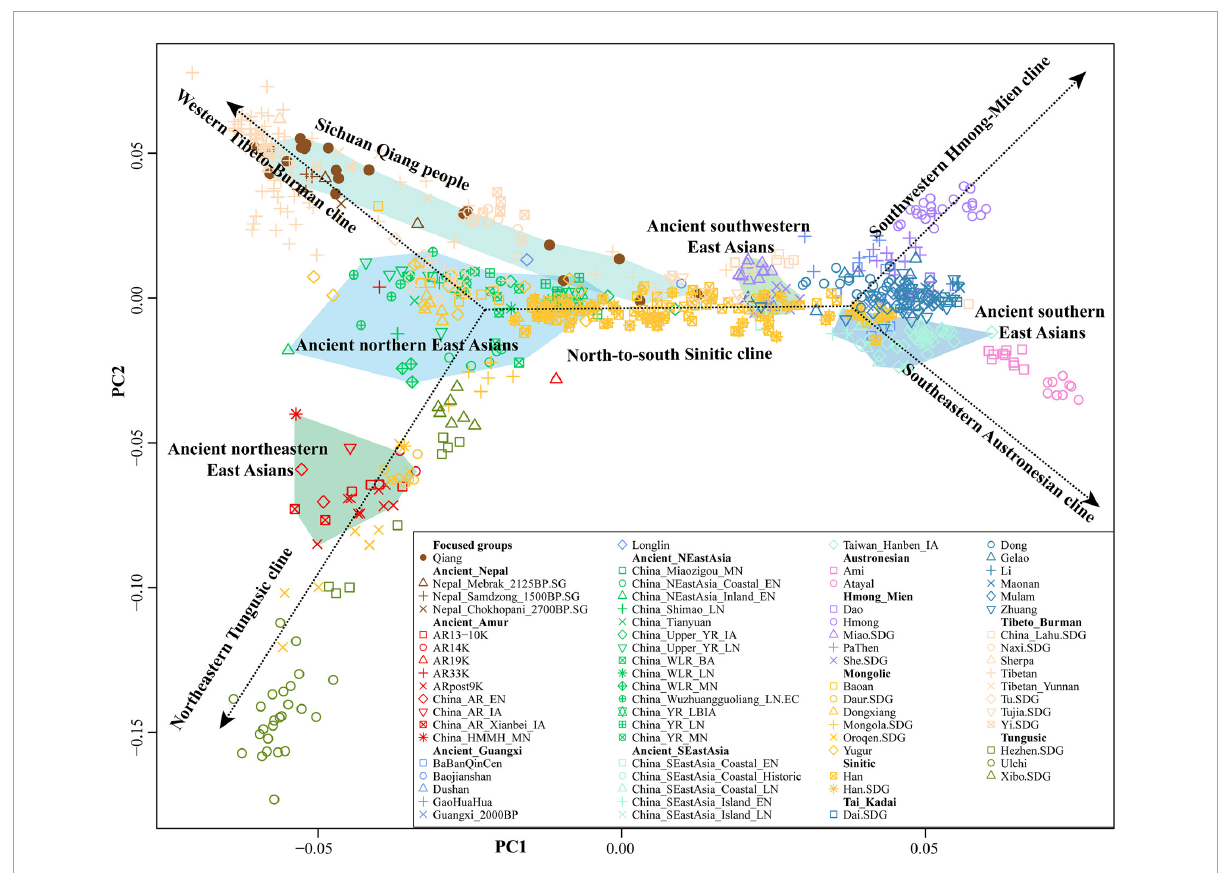
FIGURE3 Principal component analysis results of 802 East Asian individuals from 76 modern and ancient populations. Each modern population was color-coded by language family, and ancient populations were color-coded by